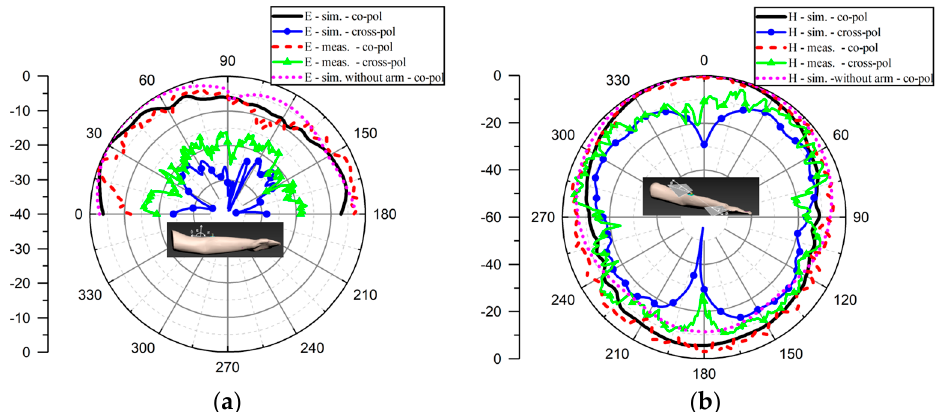
Figure 14. On-arm patterns: ( a ) E -plane and ( b ) H plane.